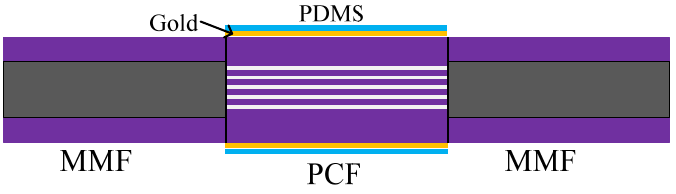
Figure 9. The description of PCF coated with PDMS based on SPR [42].